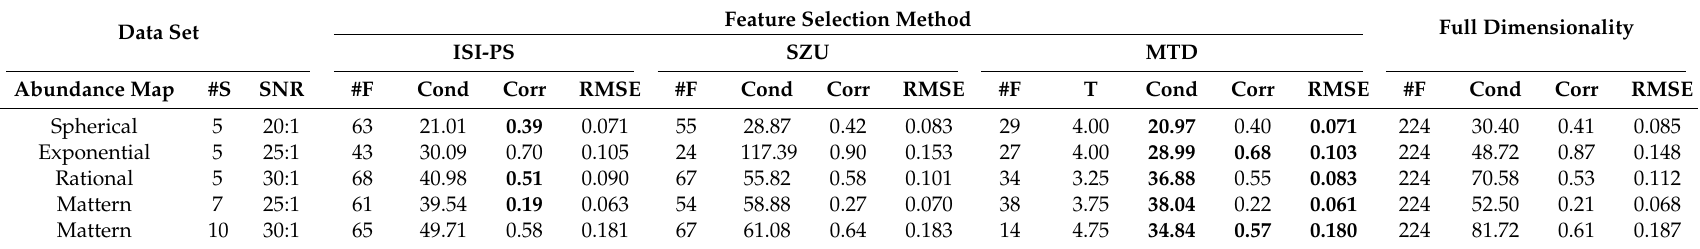
Table 2. The accuracy assessment results of the selected bands by maximum tangent discrimination (MTD), stable zone unmixing (SZU), and the proposed instability index (ISI)-prototype space (PS) algorithms, in comparison with using all bands to estimate the fractional abundances through a supervised spectral unmixing on the simulated datasets.